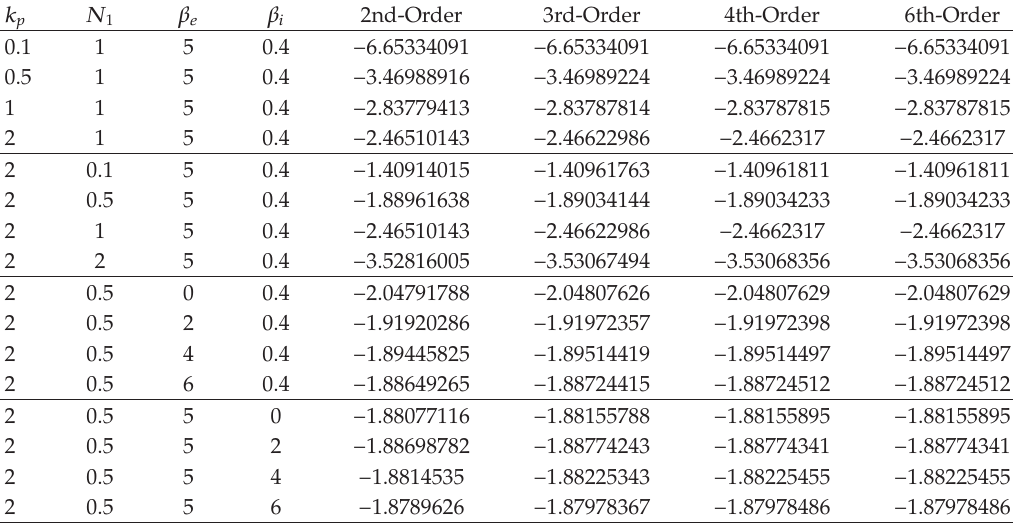
parameter (cid:6) k p (cid:7) . The local shear stress (cid:6) C fx (cid:7) increases in absolute values as the coupling parameter increases. The local wall shear stress (cid:6) C fx (cid:7) increases in absolute values when the Hall parameter or ion-slip parameter increases. The values of the wall shear stresses (cid:6) C fx , C fz (cid:7) , the local Nusselt number − θ (cid:4) (cid:6) 0 (cid:7) and the local Sherwood number − φ (cid:4) (cid:6) 0 (cid:7) for di ff erent Hartman number M , Hall parameter β e , ion- slip parameter β i , and coupling parameter N 1 are presented in Table 3. It is observed in